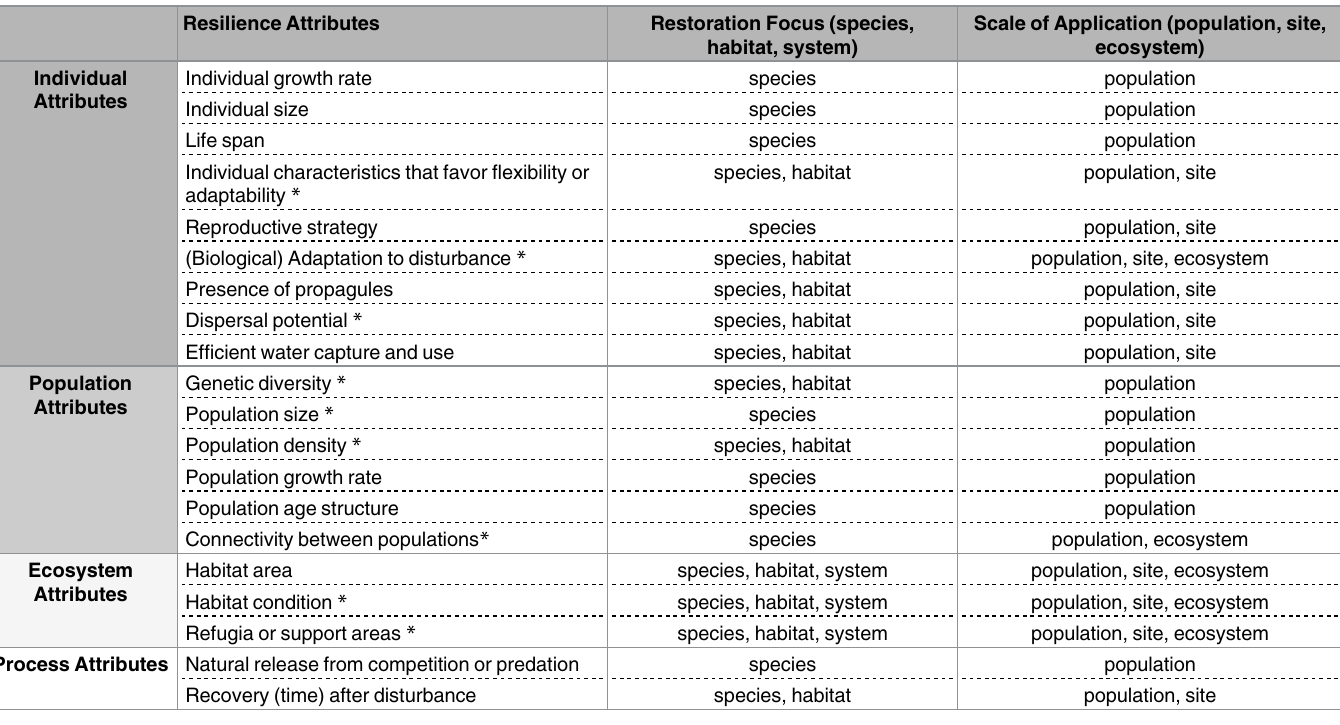
Table 4. Pacific salmon restoration